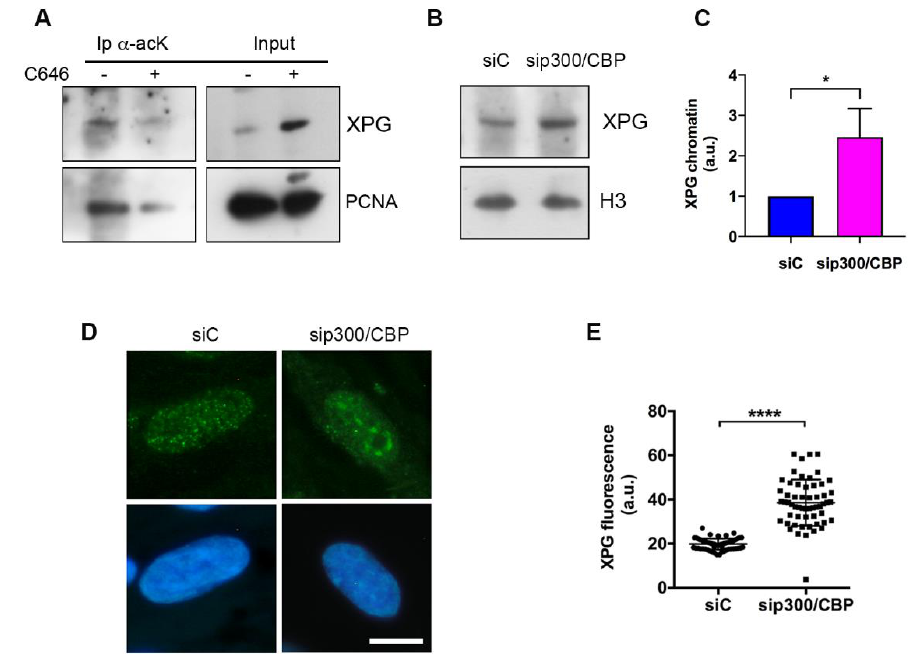
Figure 3. Inhibition of p300/CBP activity induces increase in and redistribution of chromatin-bound XPG. ( A ) Immunoprecipitation (Ip) of acetylated proteins from chromatin-bound nuclear extracts of (C) untreated or C646-treated LF-1 fibroblasts. Western blot analysis of XPG and PCNA in the input and Ip is shown. ( B ) Western blot analysis of XPG and histone H3 proteins in chromatin-bound nuclear extracts of LF-1 fibroblasts previously incubated with nontargeting siRNA (siC) or siRNA to p300 and CBP (sip300/CBP). ( C ) Densitometry quantification of XPG bands in the Western blots of chromatin-bound nuclear extracts of LF-1 fibroblasts previously incubated with nontargeting siRNA (siC) or siRNA to p300 and CBP (sip300/CBP). Densitometry values normalized to histone H3 content and given as fold value of the amount in siC samples. Mean values ± S.D. of three experiments are shown. (* p < 0.05). ( D ) Immunofluorescence staining of chromatin-bound XPG (green fluorescence) and DNA (blue fluorescence) in LF-1 fibroblasts previously incubated with nontargeting siRNA (siC) or siRNA to p300 and CBP (sip300/CBP). Scale bar = 10 μm. ( E ) Quantification of XPG fluorescence intensity in LF-1 fibroblasts prepared as in ( D ). Fluorescence was quantified by Image J as described in Materials and Methods. At least 50 cells (from two independent experiments) were analyzed. Error bars show SEM (**** p <